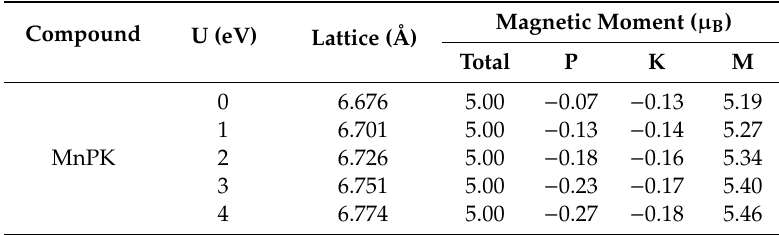
Table 1. The calculated equilibrium lattice constants and the corresponding total and atom-resolved magnetic moments of half Heusler compound MnPK under different Hubbard U values.